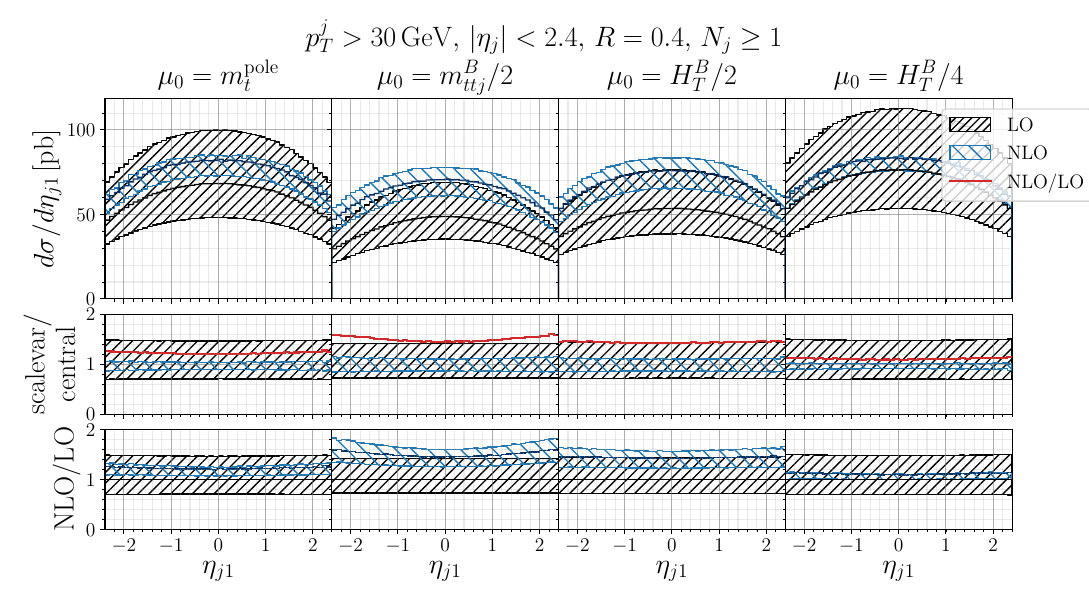
Figure 15 . Same as in figure 7, but for the η j